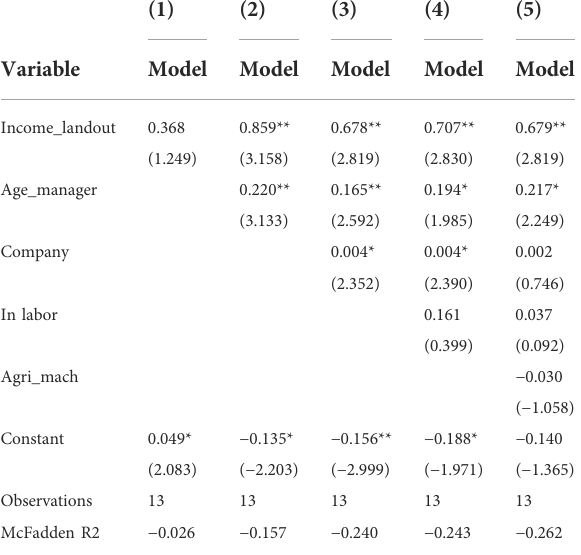
TABLE7Tobitregressionanalysisresultsofin fl uencingfactorsofrural land outsourcing in